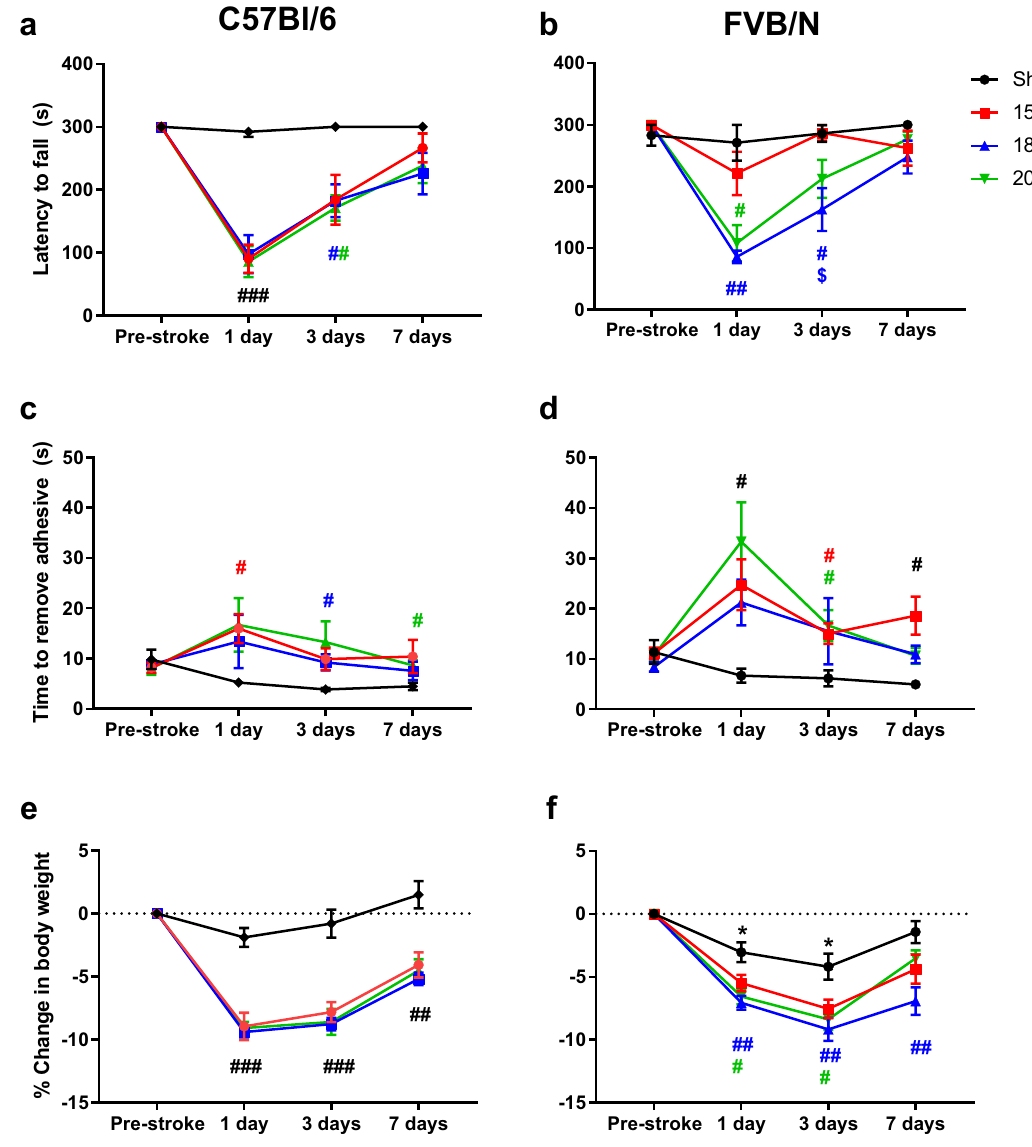
Figure 2. C57Bl/6 mice have greater motor impairment and stroke-induced weight loss compared to FVB/N mice. In contrast, FVB/N mice are more sensitive to the adhesive removal test. Effects of light exposures of 15 (C57Bl/6 n = 8, FVB/N n = 16), 18 (C57Bl/6 n = 10, FVB/N n = 14), and 20 min (C57Bl/6 n = 8, FVB/N n = 15) during stroke induction, prior to stroke, and 1, 3, and 7 days after stroke on: The hanging wire test in C57Bl/6 mice ( a ) or FVB/N mice ( b ), expressed as latency to fall (s); the adhesive removal test for C57Bl/6 ( c ) and FVB/N ( d ) mice, expressed as time to remove adhesives (s); change in body weight for the C57Bl/6 ( e ) and FVB/N ( f ) strains of mice, expressed as a change in percentage of the pre-stroke baseline weight. Data are presented as mean ± SEM, with *P < 0.05 vs pre-stroke, # P < 0.05, ## P < 0.01, ### P < 0.001 vs sham, $ P < 0.05